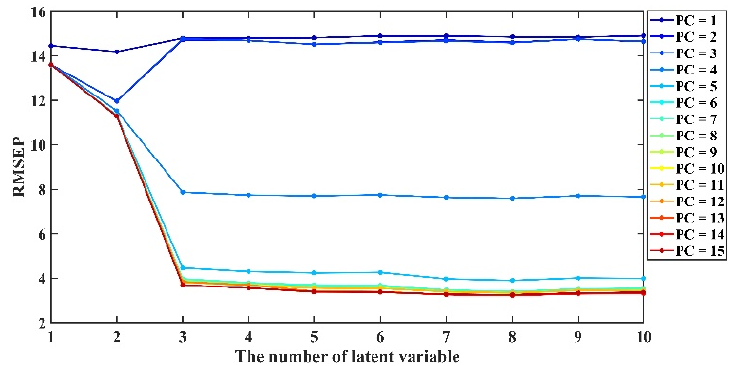
Figure 2. RMSEP results under different PCs and LVs with IPCA for transfer from target to source (different PCs in IPCA algorithm and different numbers of LVs in PLS regression).